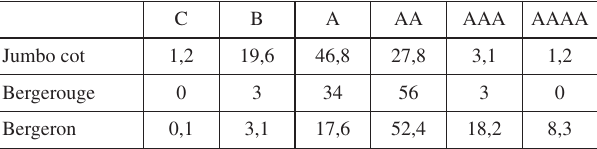
Table 7. Size distribution of some apricot